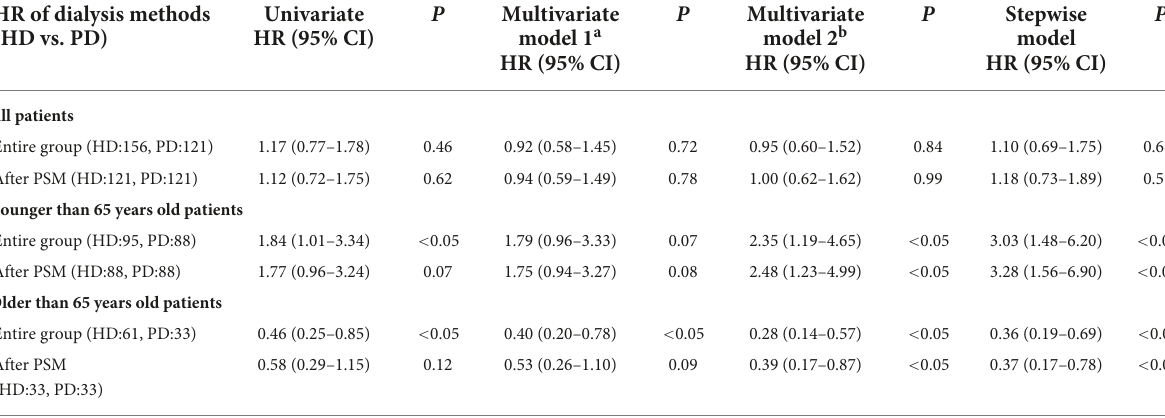
TABLE 4 Crude and adjusted hazard ratios for all-cause mortality according to dialysis method. HR of dialysis methods (HD vs. PD)